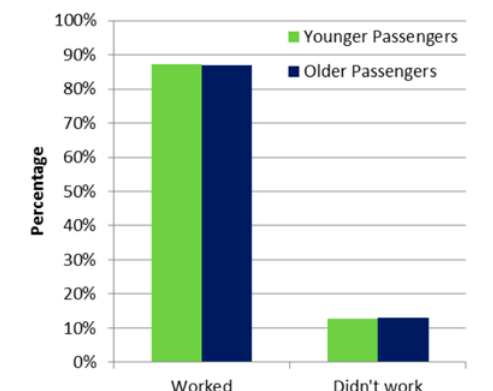
Fig. 3. Ease of use by